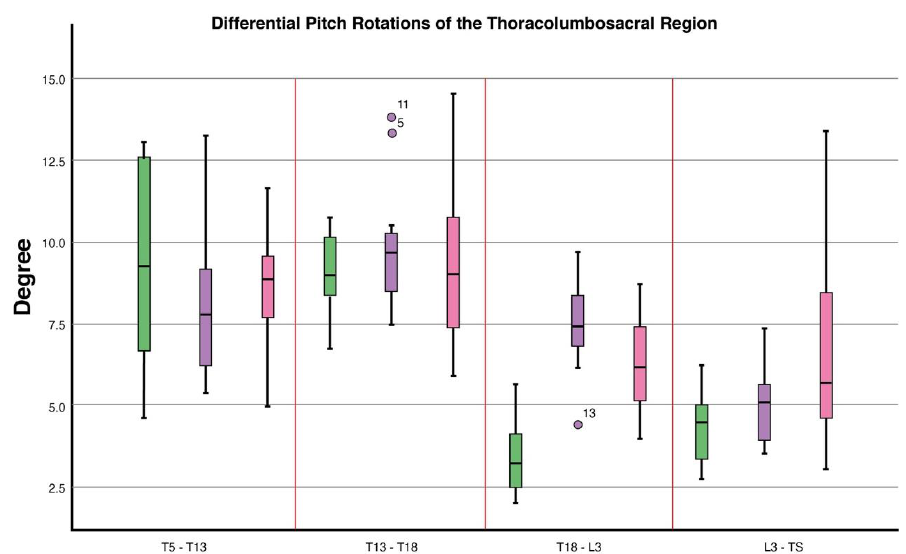
Figure 4. Boxplots displaying differential pitch rotations of the thoracolumbosacral spine in 10 dressage horses whilst trotting in-hand and when being ridden in sitting trot and canter. At T18-L3, differential pitch rotations differed between conditions ( p = 0.01) where an increase in differential pitch rotations when in sitting trot ( p ≤ 0.0001) and canter ( p ≤ 0.0001) was found when compared to trotting in-hand. At L3-TS differential pitch rotations differed between conditions ( p = 0.005) where an increase in differential pitch rotations was Figure 0. when compared to trotting in-hand. In canter, differential pitch rotations increased when compared to sitting trot ( p = 0.01). Explanation of symbols: the central line represents the median; the box represents the 25th and 75th percentiles; the whiskers represent the maxima and minima not considered to be outliers; ° represents outliers. Boxplot ID: green = in-hand trot, purple = sitting trot and pink = canter.